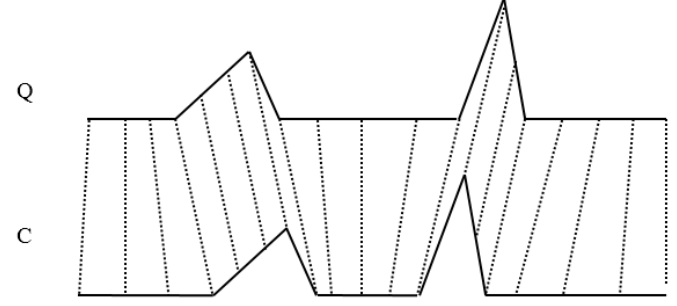
Figure 5. Feature points alignment in dynamic time warping (DTW).